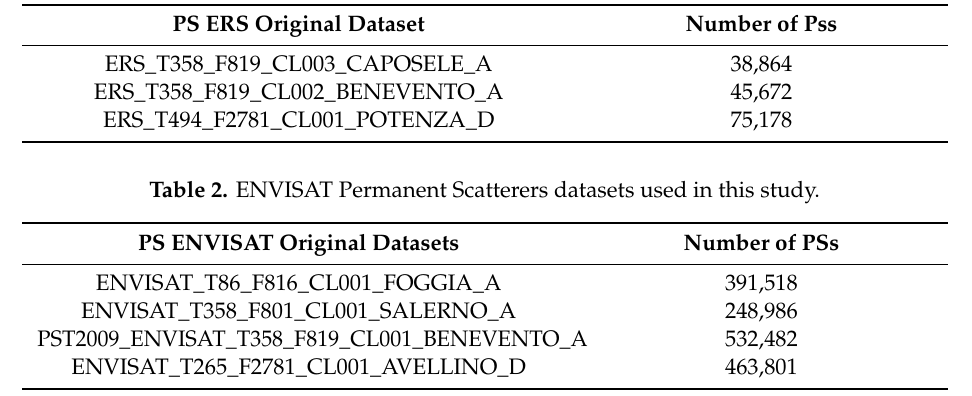
Table 1. ERS Permanent Scatterers datasets used in this study.